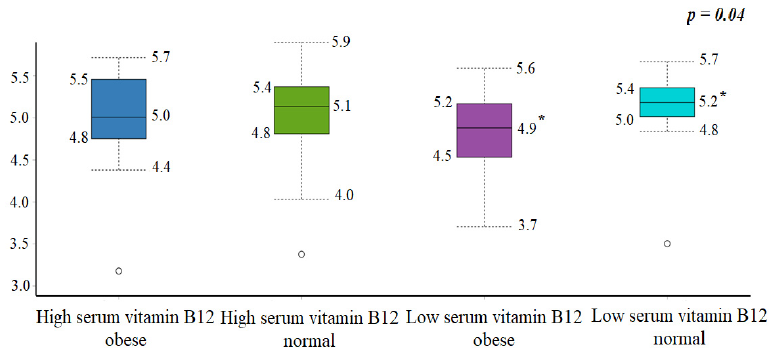
Figure 3. Comparison of bacterial α -diversity (Shannon–Wiener index) between the microbiota of normal-weight and obese participants based on BMI and serum vitamin B12 status (<404.0 pg/mL). * p <